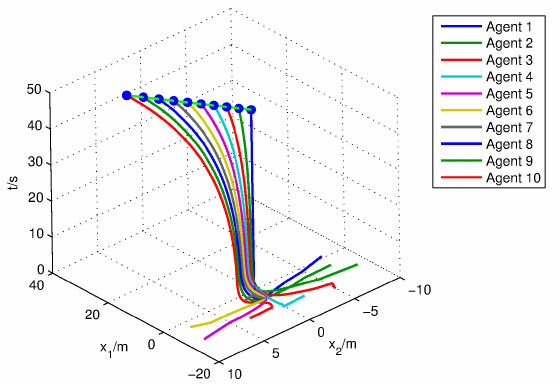
Figure 1. The spatio-temporal trajectory of mobile sensors.